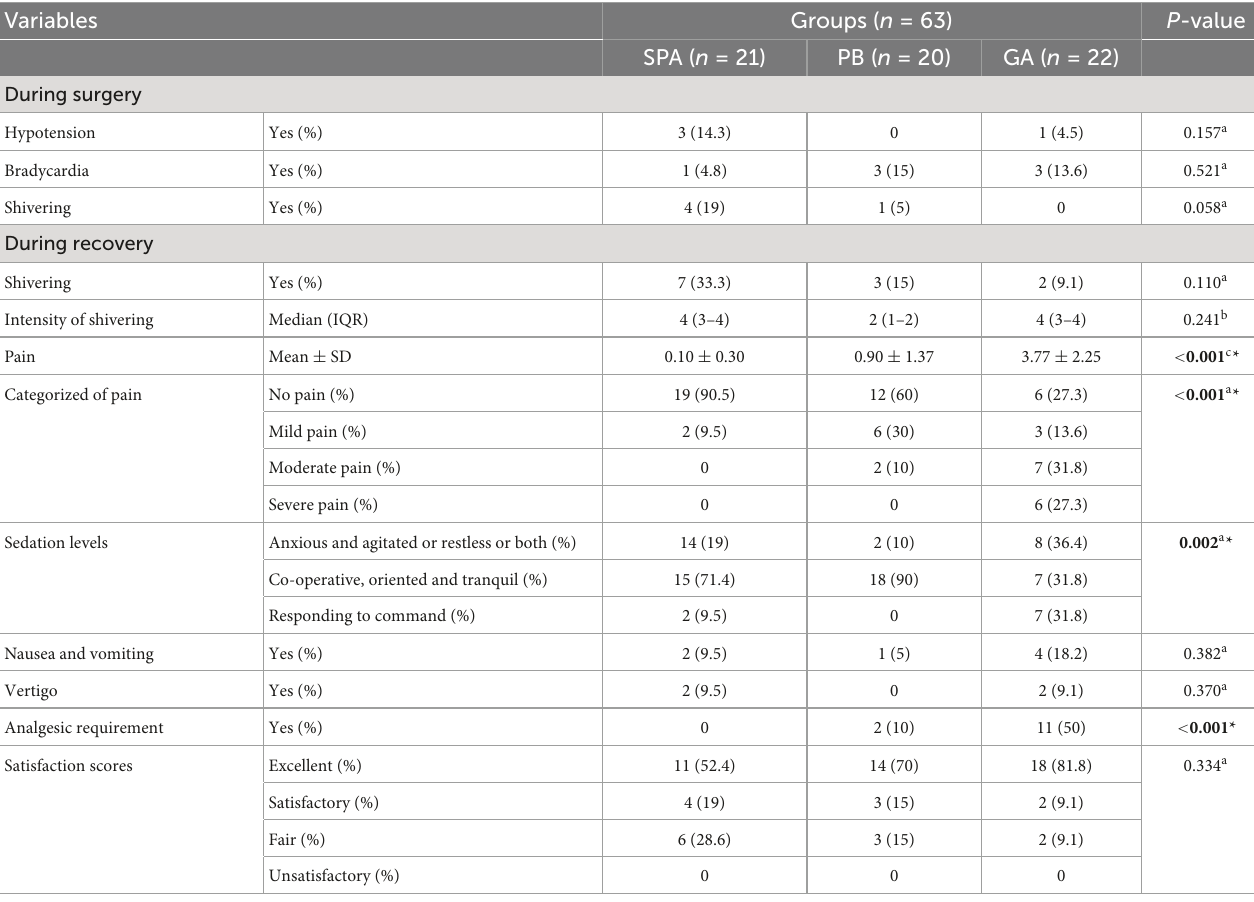
TABLE 3 Comparison of complications (during surgery and recovery), sedation level and satisfaction scores among three study groups. Variables